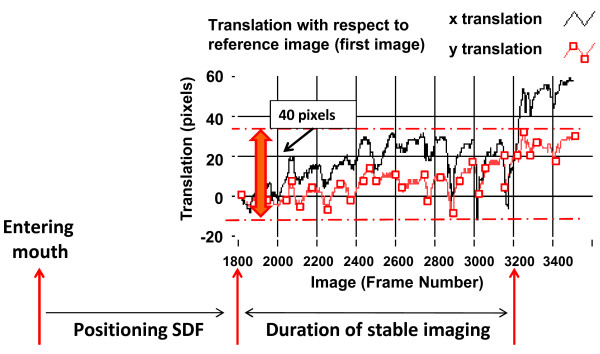
Assessment of image stability. Image drifting was measured as the translation (in pixels) of an image with respect to the first image of a video sequence. Image drift of 40 pixels, in either x- or y- direction, was arbitrarily chosen as a cut off for a stable video sequence.